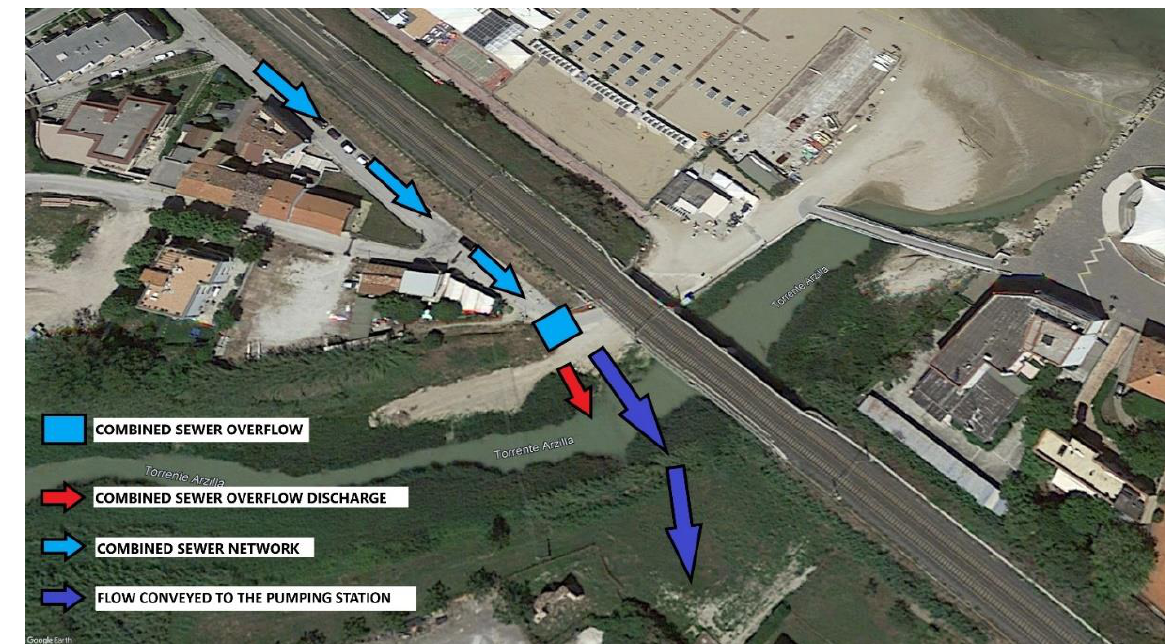
Figure 3. State of the site before the intervention .